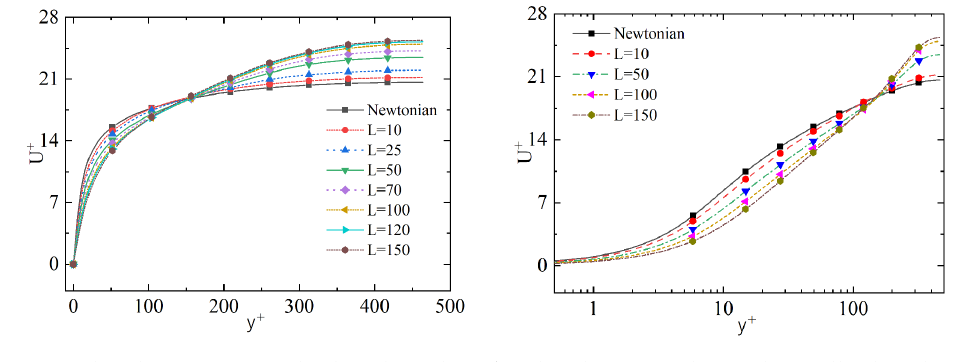
U  ) of different maximum extensibility of the pol ‐